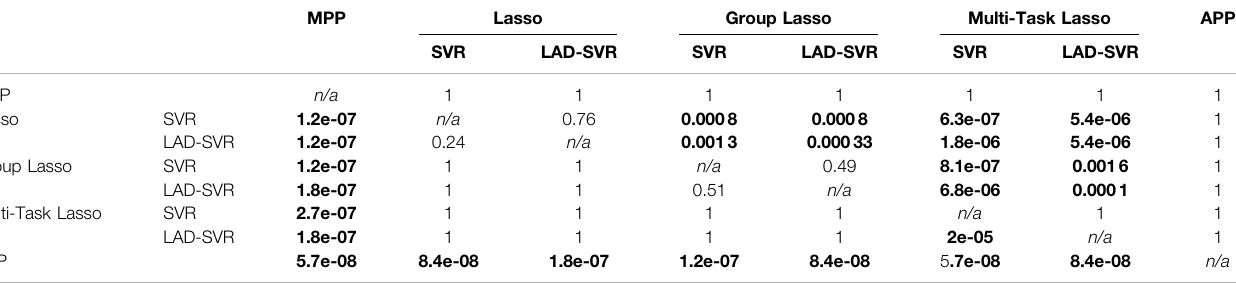
TABLE3| The p -valuesassociatedwithone-sidedWilcoxonsigned-ranktestsindicatingwhetherthepreoperativeplanningmethodsinthe fi rstcolumnareanimprovement upon the preoperative planning methods in the fi rst row. Values in bold are statistically signi fi cant improvements. MPP